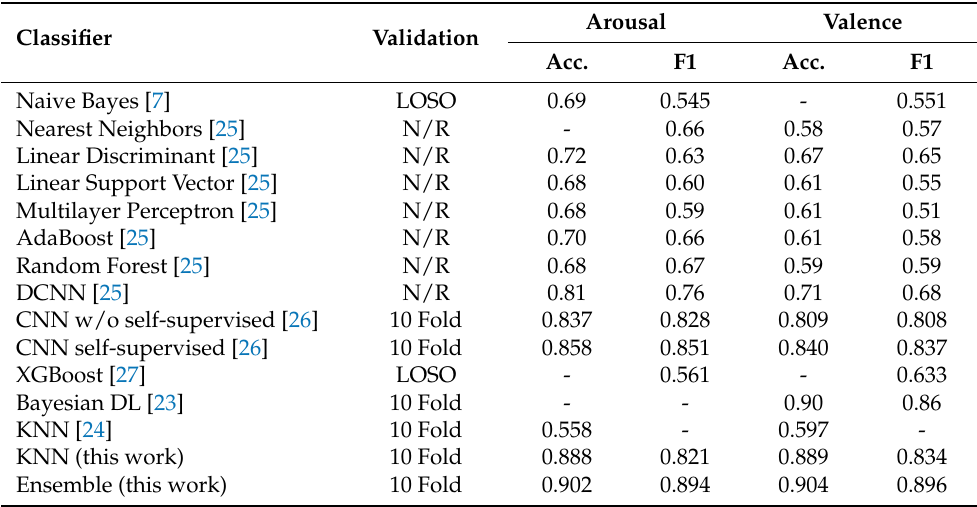
Table 5. Comparison of the results from previous studies that use AMIGOS